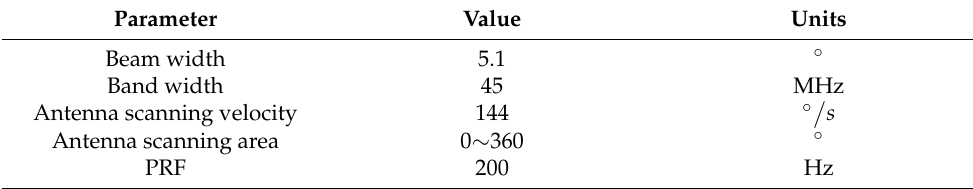
Figure 9. Optical scene of the roof. Table 6. System parameters of roof